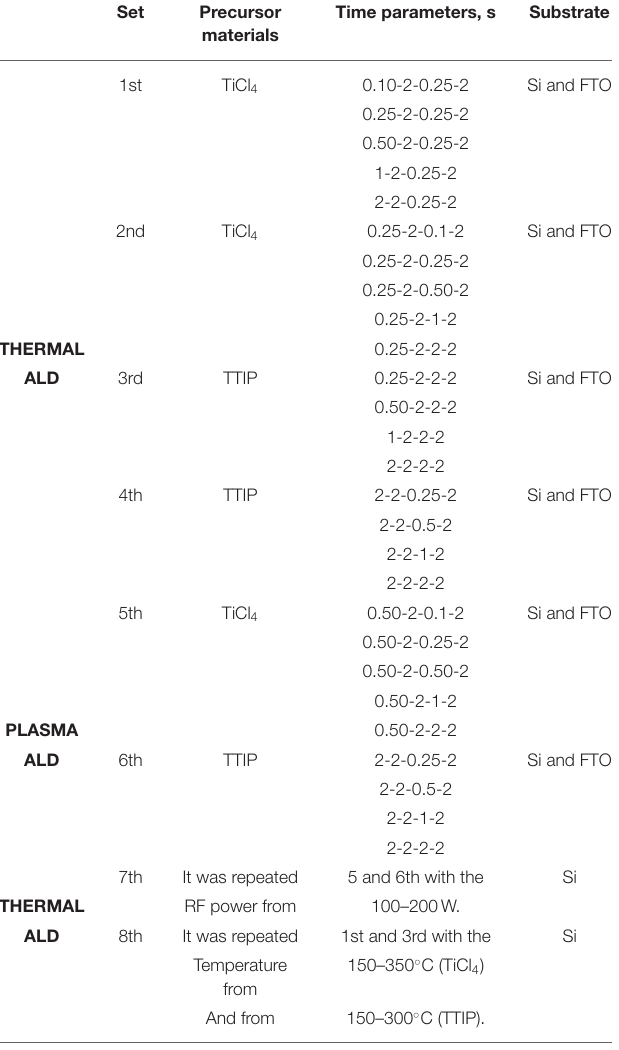
TABLE 1 | Pulse time (Ti precursor-Purge-Oxidant Precursor-Purge) varying and temperature at 250 ◦ C for the first to the sixth set of samples.